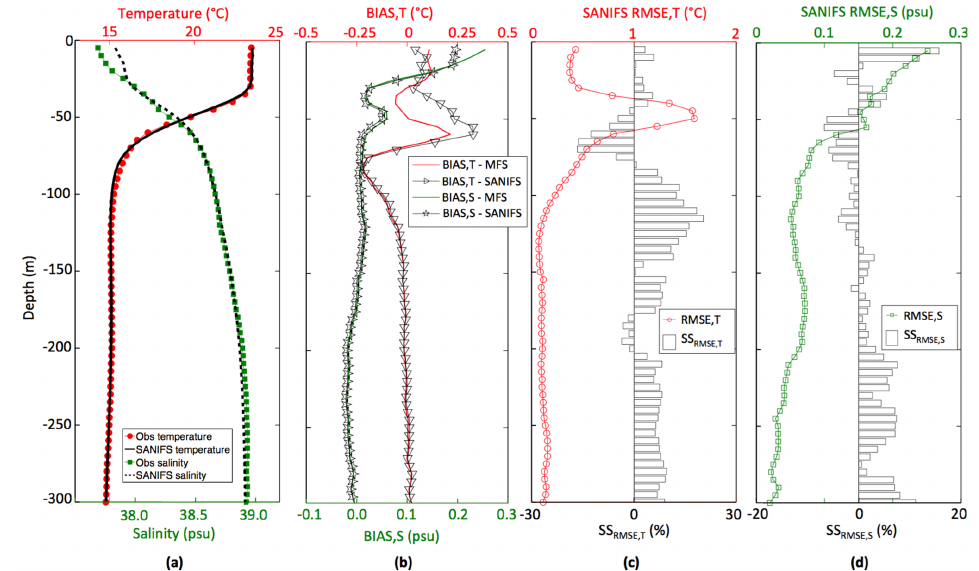
Figure 8. SANIFS average profiles (temperature and salinity) compared with the observed ones for the LS2 (a) . Bias with LS2 observations of the MFS and SANIFS average profiles (temperature and salinity) (b) . Temperature RMSE for SANIFS (red line with circles) and RMSE skill score compared with reference model MFS for the LS2 (c) . Salinity RMSE for SANIFS (green line with squares) and RMSE skill score compared with reference model MFS for the LS2 (d) . RMSE skill score is represented by histograms (positive values highlight levels where SANIFS produces more accurate forecasts than MFS; conversely, negative values show the